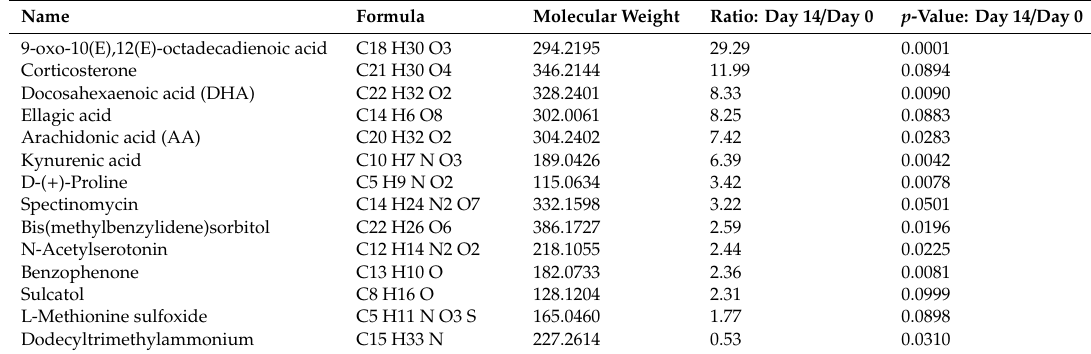
Table 1. Metabolite alterations in fecal samples after a two-week supplementation with walnuts ( n = 3 /